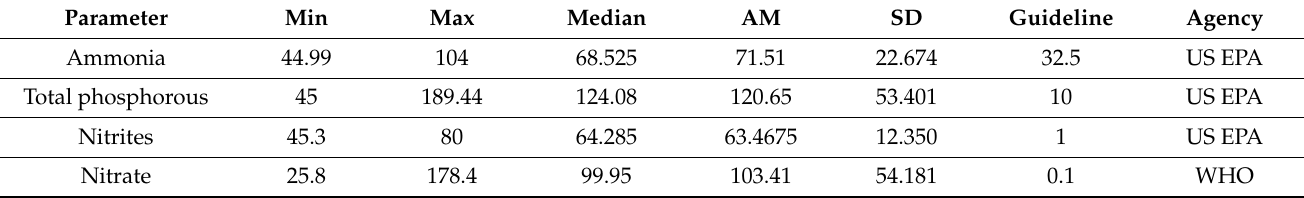
Table 1. Characteristics of the poultry slaughterhouse raw wastewater ( n = 12).